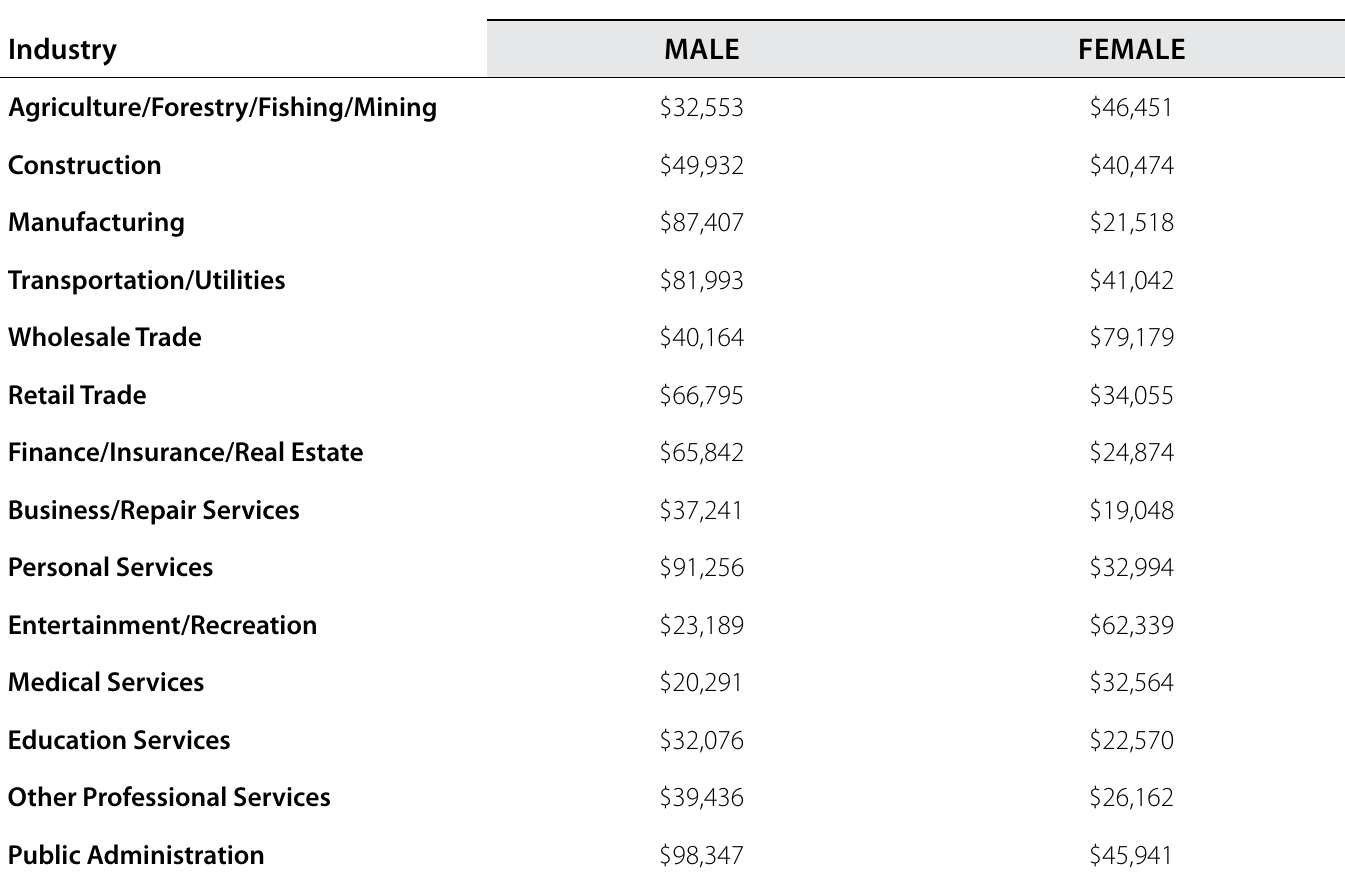
Table 4b. Mean Earnings by Gender and